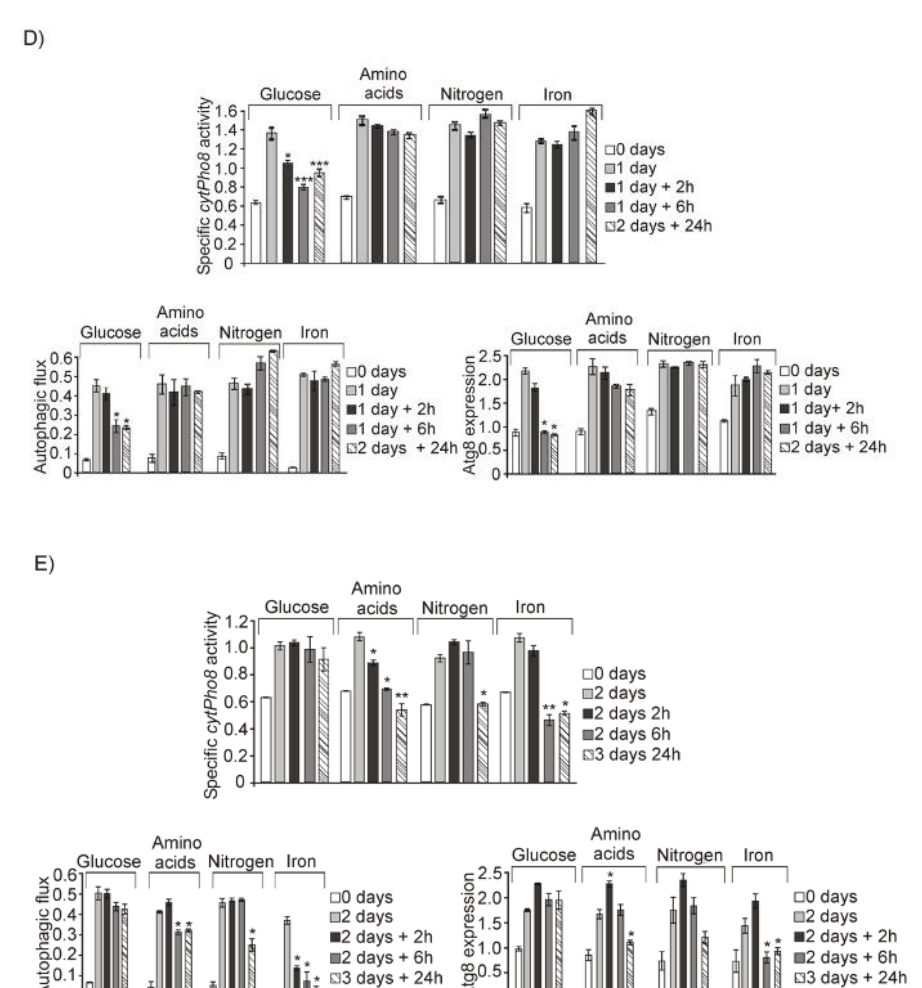
Figure 1. Sequential decreases of glucose and amino acids activates bulk autophagy during the diauxic shift in Saccharomyces cerevisiae . ( A ) wt cultures in which the fusion protein GFP–Atg8 or Atg1HA were integrated, were grown to log phase (OD 600 : 0.6) in SD medium at 30 ◦ C. Aliquots were collected at the indicated times for total protein extraction and Western blot analysis. GFP–Atg8 was monitored using an anti-GFP antibody. We used anti-PGK1 to detect Pgk1 as a loading control. Microscopic observation of GFP–Atg8 was carried out using a fluorescence microscope. GFP vacuolar accumulation was also determined upon the use of the fluorescent dye FM4-64. Autophagic flux was calculated as the ratio of free GFP and total GFP–Atg8 in the samples. Total GFP–Atg8 was determined as the addition of the form GFP–Atg8 and the band corresponding to free GFP, as a result of Atg8 vacuolar degradation, both detected by Western blot. Enzymatic autophagy activity was measured by using the alkaline phosphatase assay in the strain BY4741 pho8 ∆ expressing a plasmid with the inactive Pho8 proenzyme targeted to the cytosol. Values of Atg1 proteins were determined upon Western blot analysis using anti-HA antibody. ( B ) atg7 and atg11 strains expressing the fusion protein GFP–Atg8 were grown in the same conditions as described in A. Autophagic flux and total Atg8 expression were determined as in ( A ). ( C ) Glucose content in the culture medium (%) was determined in wt cultures growing in SD media at 30 ◦ C at the days indicated in the table for a total period of 15 days. Glucose in the sterile media, SD, at a final concentration of 2%, is the equivalent of 100% in the table. ( D ) wt cells bearing GFP–Atg8 in their genome were exponentially grown at OD 600 :0.6 at 30 ◦ C in SD media and a sample was collected for analysis. Upon one day of culture, 2% glucose, amino acids (60 mg/mL leucine, 20 mg/mL histidine, and 20 mg/mL tryptophan), 0.67% nitrogen or 10 mM iron, were respectively added to the cultures and samples were collected at 2, 6, and 24 h to perform pho8 ∆ 60 enzymatic assays. Autophagic flux and GFP–Atg8 total expression were determined as previously detailed in A. Enzymatic autophagic activity was determined as in ( A ). ( E ) As in ( D ), but results correspond to two days of growth. Error bars in the histograms represent the standard deviation (SD) calculated from three independent experiments. Significance of the data was determinate by p -values from a Student’s unpaired t -test denoted as follows: * = 0.05 > p > 0.01; ** = 0.01 > p > 0.001; *** = 0.001 > p > 0.0001; **** = p >